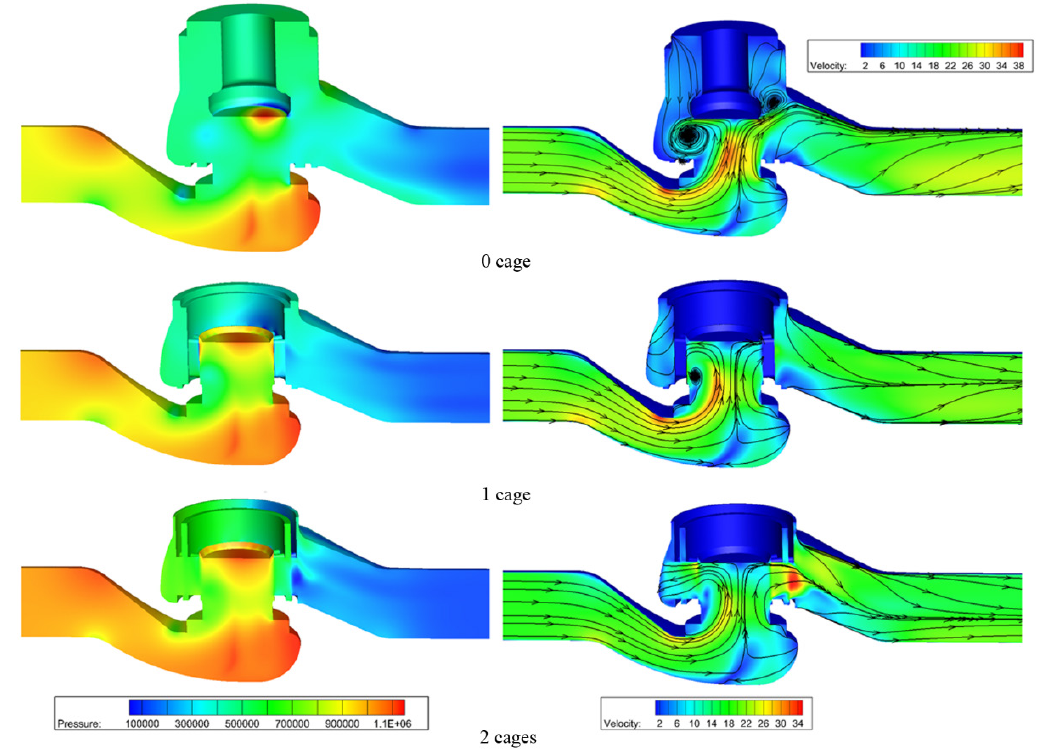
Figure 4. Velocity and pressure distributions for the globe valve with a different number of cages.